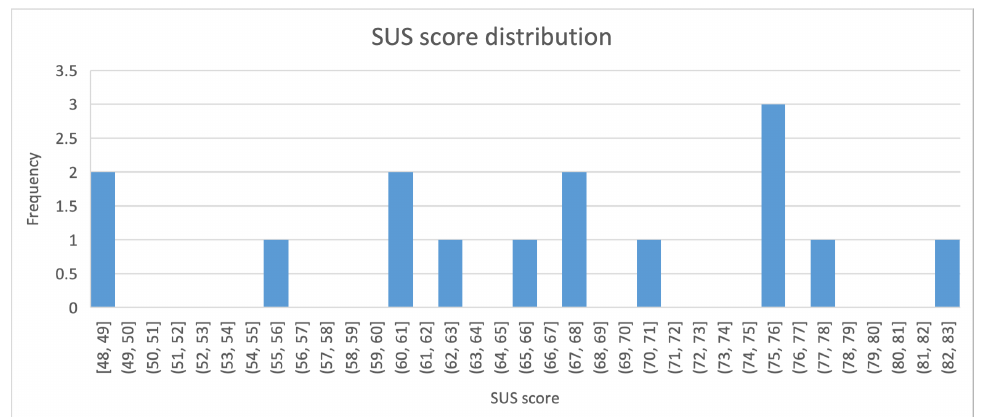
Figure 16. SUS scores of the interface developed for the analysis of plant growth use case. The X-axis indicates a certain range of the score. The Y-axis indicates the number of participants who gave the score within the range.